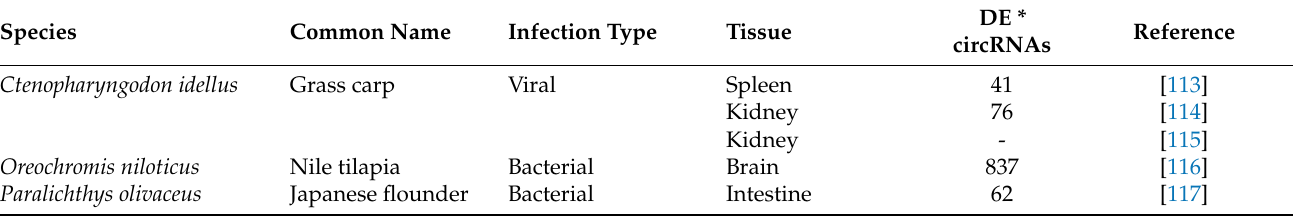
Table 3. CircRNAs associated with teleost immunity and differentially expressed after viral or bacterial infection.